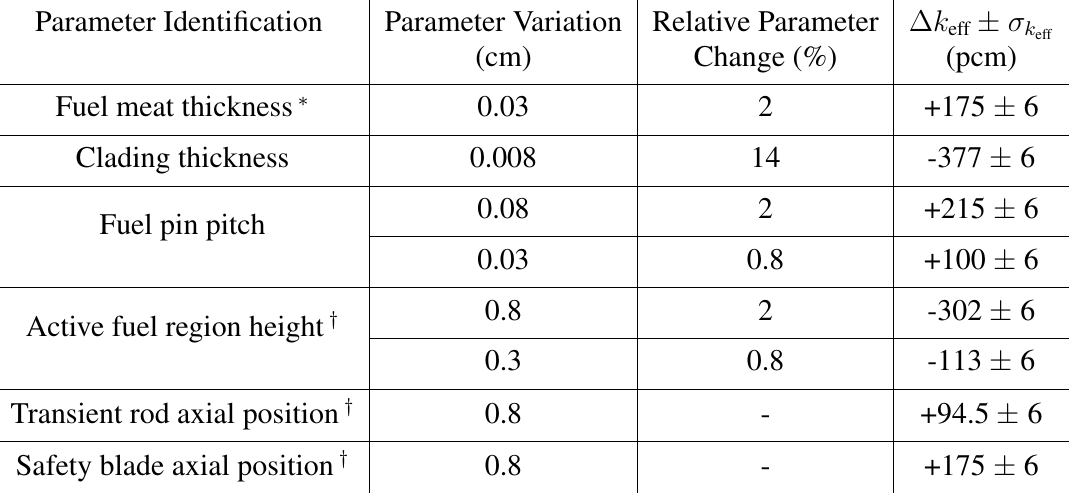
Table 1: Effect of Uncertainty in Model